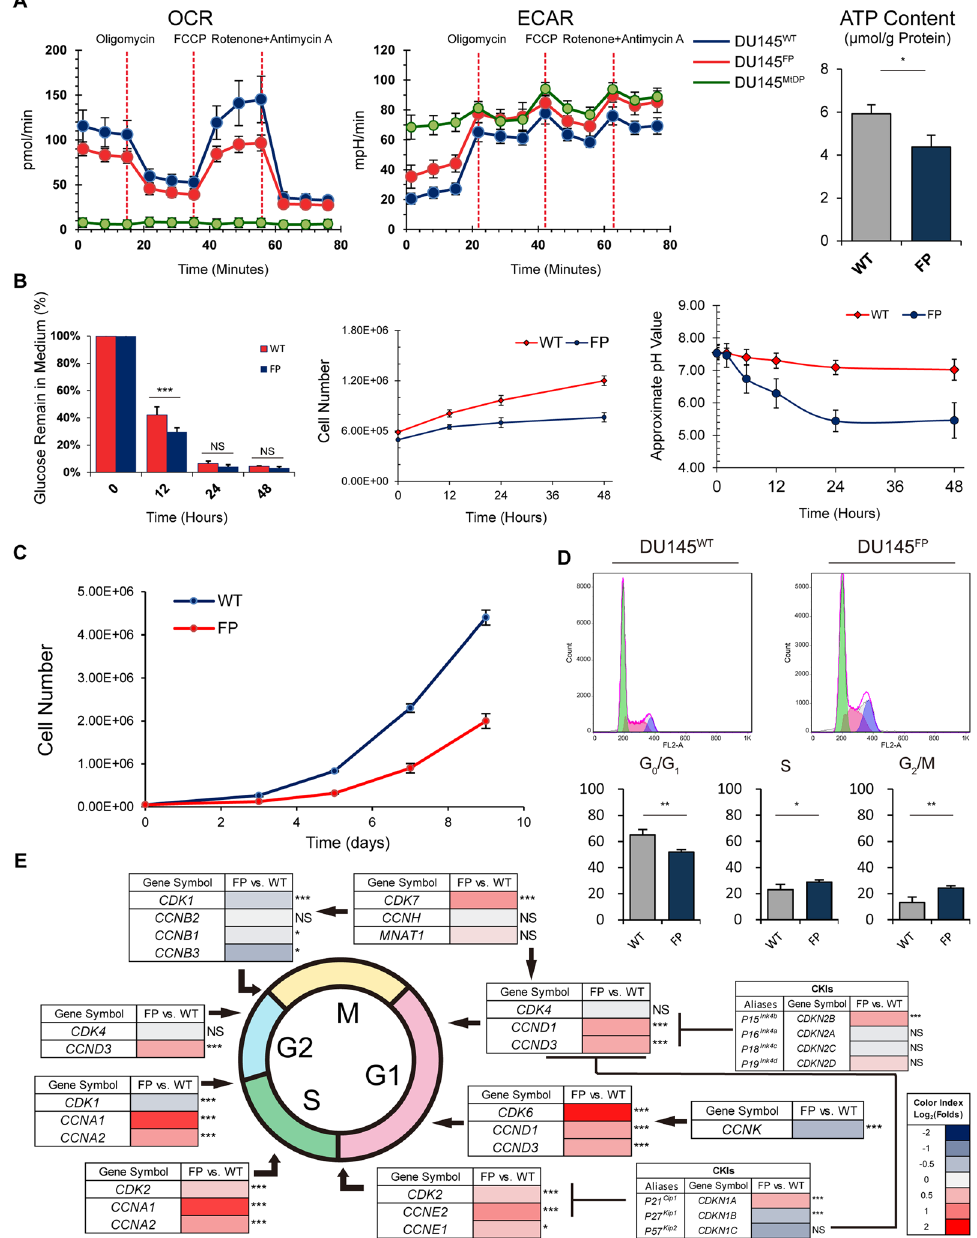
Figure 3. DU145 FP cells show reprogrammed metabolism and are slow cycling. ( A ) The Seahorse XF Cell Mito Stress assay were applied to show cells’ mitochondrial respiration capacity and metabolic preference. The intracellular ATP concentrations are measured based on bioluminescence assays. The data is presented as means from three independent experiments, each experiment includes at least three parallel samples (mean ± S.D). ( B ) The glucose consumption status at 12, 24 and 48 hours are shown in line charts, and corresponding cell counting results are presented by line charts in the middle. For the long-term extracellular acidification analysis, all cells were maintained in non-buffered Seahorse medium for 12, 24 and 48 hours. Then the approximate pH values of cell culture supernatants were measured and shown in the line charts on the right. The data is presented as means from three independent experiments, each experiment includes two parallel samples (mean ± S.D). ( C ) Cell growth curves obtained from the MTT assay in a period of 0–11 days. After 11 days of cultivation, the relative cell density is estimated by the absolute OD value. The data is presented as means from three independent experiments (mean ± S.D). ( D ) The cell cycle is analyzed by PI staining by flow cytometry. A representative group of analyses is shown in the histograms, and the Watson’s model is applied to separate the different cell phases. The data is presented as means from five independent experiments (mean ± S.D). ( E ) Transcriptome analyses showing up- or down-regulation of cell cycle-related molecules including CDKs, CKIs and cyclin members. The color-coded bars index Log 2 transformed ratio of FPKM values (e.g., FP/WT). Statistical significance: * p < 0.05, ** p < 0.01, *** p <